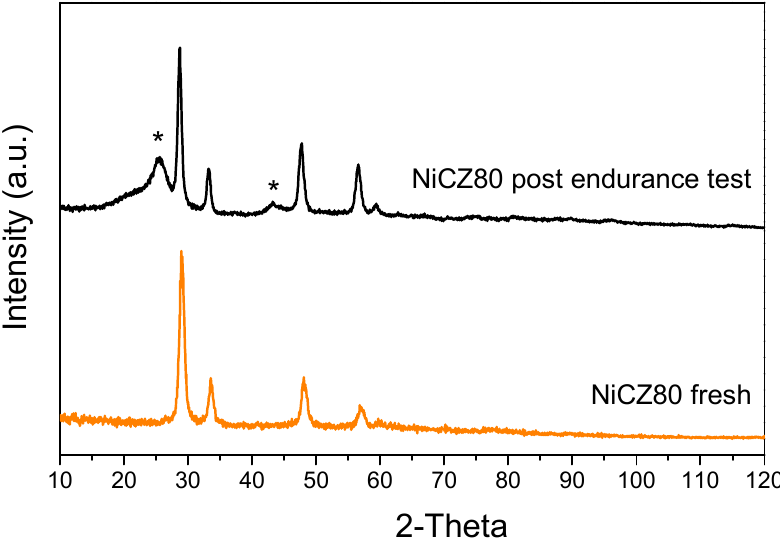
Figure 14. X-ray diffraction spectra of NiCZ80 catalyst, fresh and after endurance test. The value of d 002 (3.395 Å) for the peak of the doped catalyst was far from the theoreti- cal value, so amorphous carbon instead of ordered graphite was obtained. As is well known, the nature of coke formed during the reaction influences the deactivation of catalysts [32]. Therefore, some forms of carbon reduce the catalytic activity and others do not. For high temperatures (>650 ◦ C) graphitic carbon species were formed over the undoped catalyst, encapsulating the metallic surface [32]. The above observation on coke formation led to the conclusion that doping addresses the methanation to be a coke-insensitive reaction.